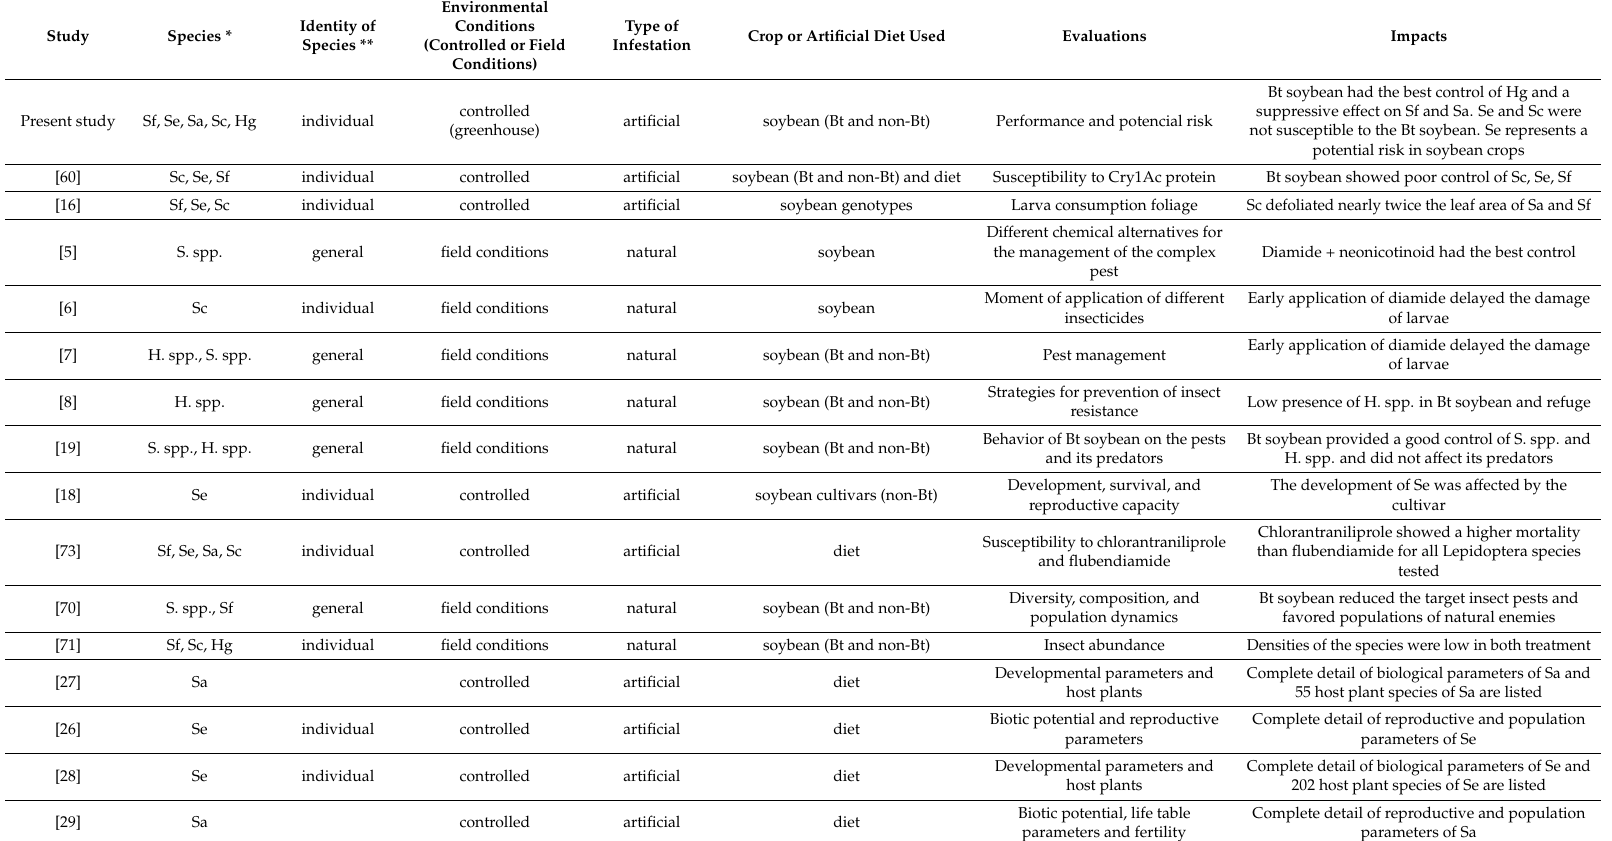
Biotic potential, life table parameters and